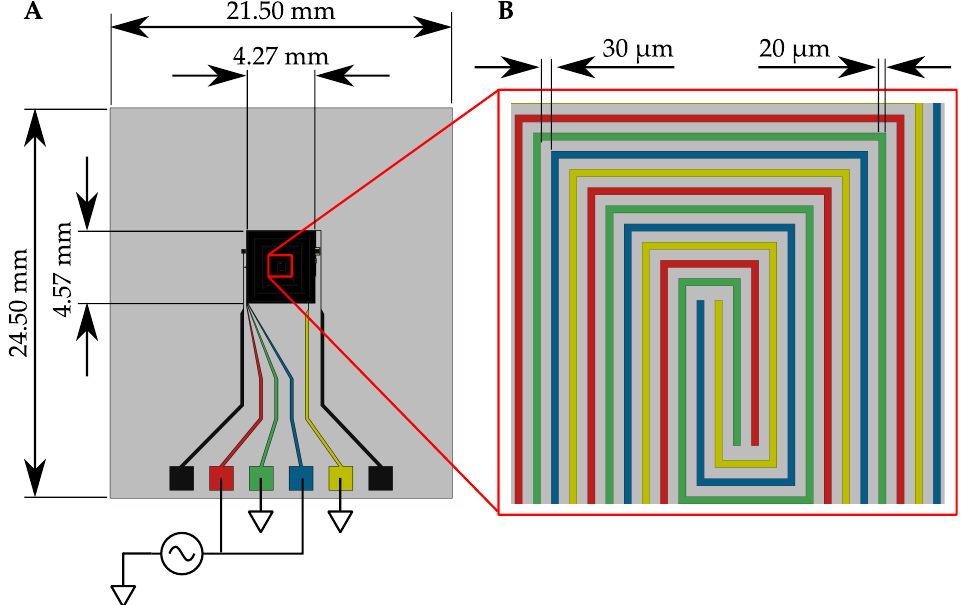
Figure 16. ( A ) The microfabricated DEP electrode array for MP particle manipulation in liquid. ( B ) A close up of the array’s spiral pattern and trace widths and intra-electrode spacing. The spiral pattern provides an extended surface for capturing particles in the